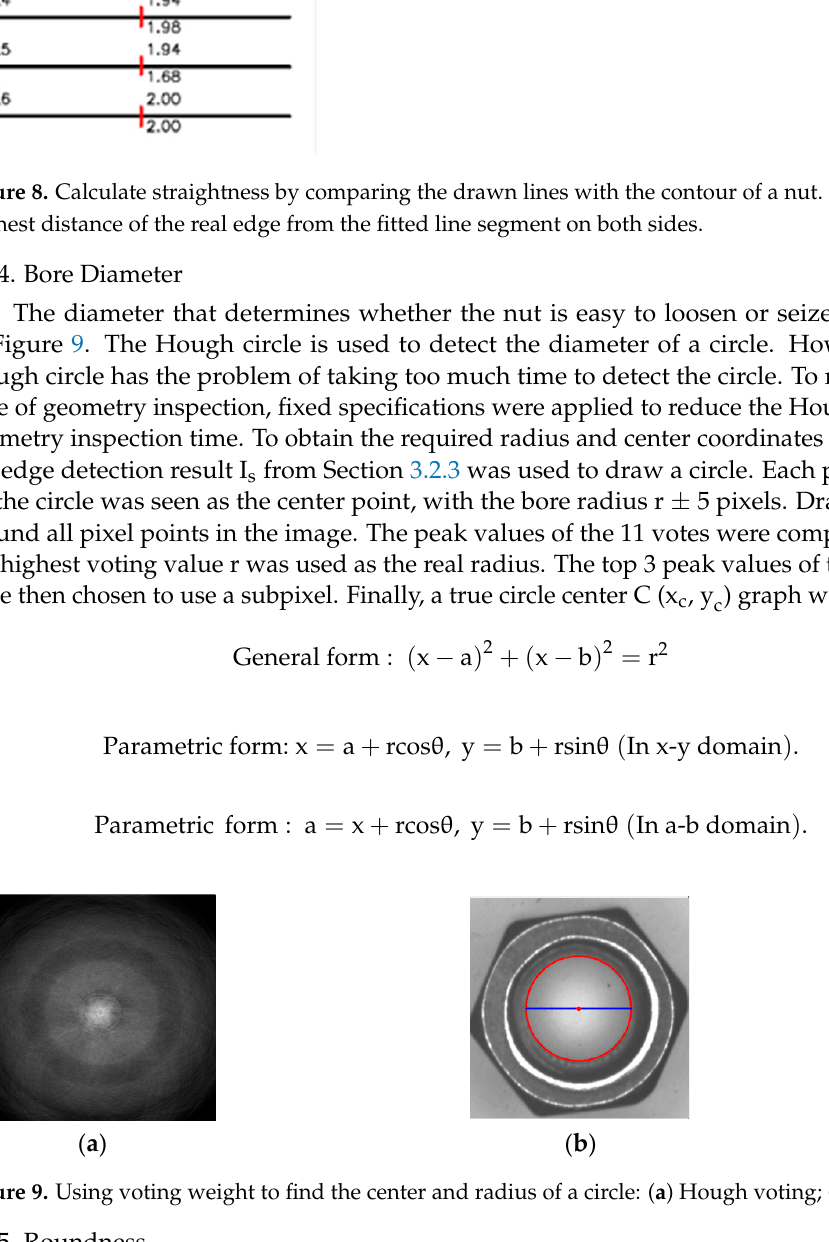
Figure 9. Using voting weight to fi nd the center and radius of a circle: ( a ) Hough voting; ( b ). Radius. 3.2.5. Roundness As shown in Figure 10, the roundness was calculated. If the roundness is not good enough, the nut might be unevenly stressed. The uneven force might cause damage and result in the nut falling o ff . The center coordinates taken from Section 3.2.1 and the radius r ± 15 pixel were used to draw two circles, and the ROI range is between the two circles. The distance D0~D359 from C(x,y) to each angle and edge of the bore was calculated, within which the D (cid:2923)(cid:2911)(cid:2934) – D (cid:2923)(cid:2919)(cid:2924) were considered to indicate true roundness R d . When R d ex- ceeds the threshold value, we know that the bore is not quali fi ed.